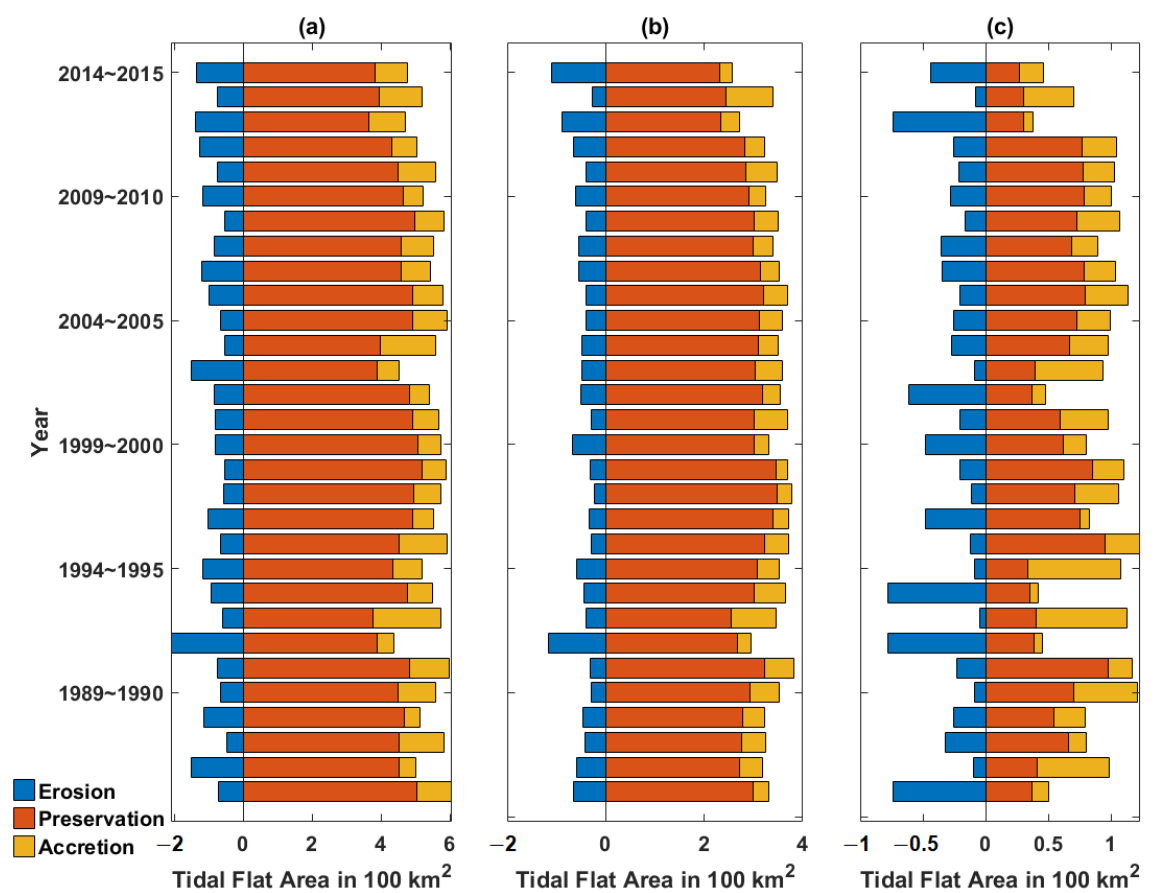
Figure 4. The annual distribution of tidal flat erosion, accretion, and preservation areas in ( a ) Charleston, SC; ( b ) Chatham, GA; and ( c ) Duval, FL.